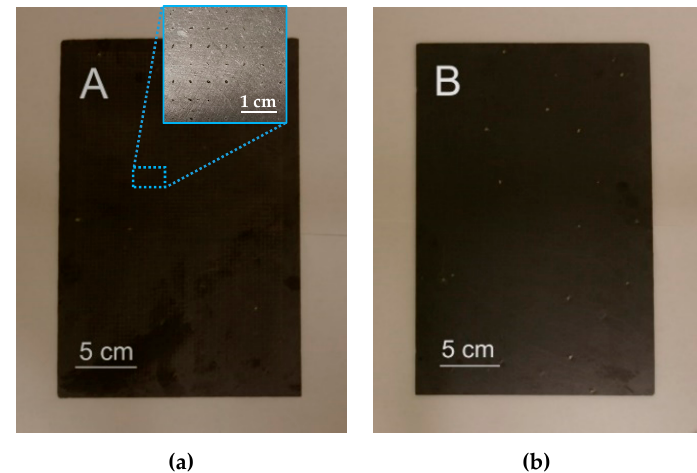
Figure 7. ( a ) Hole performed in a 5 mm thick slate using a conventional drilling tool (1.5 mm in diameter). Examples of typical breaking modes after conventional drilling processes: ( b ) cracking and ( c ) foliating.